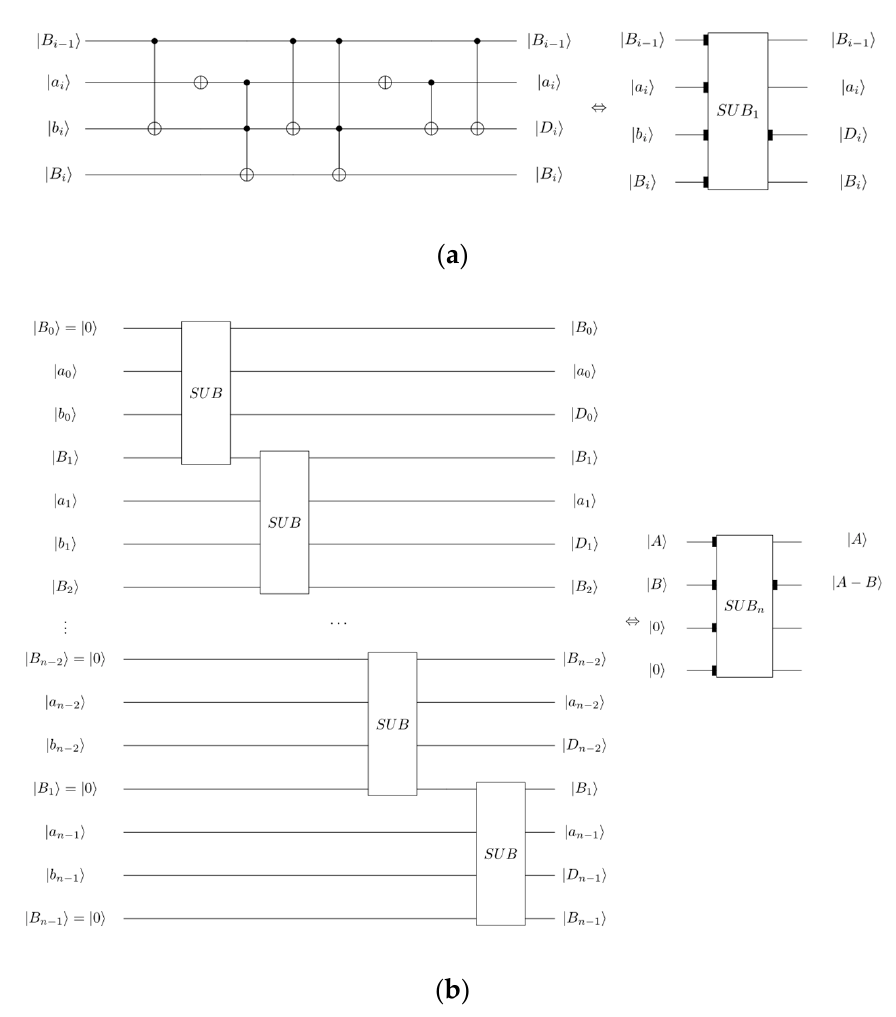
Figure 9. Full subtractor circuit. ( a ) 1-bit full subtractor circuit. ( b ) n-bit full subtractor circuit.